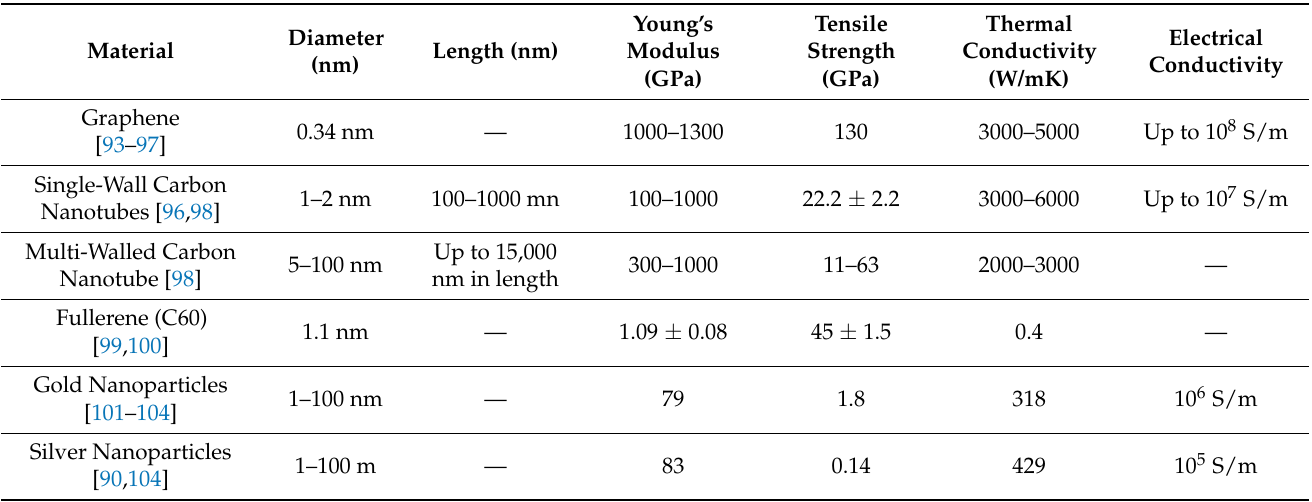
Table 2. Mechanical properties of